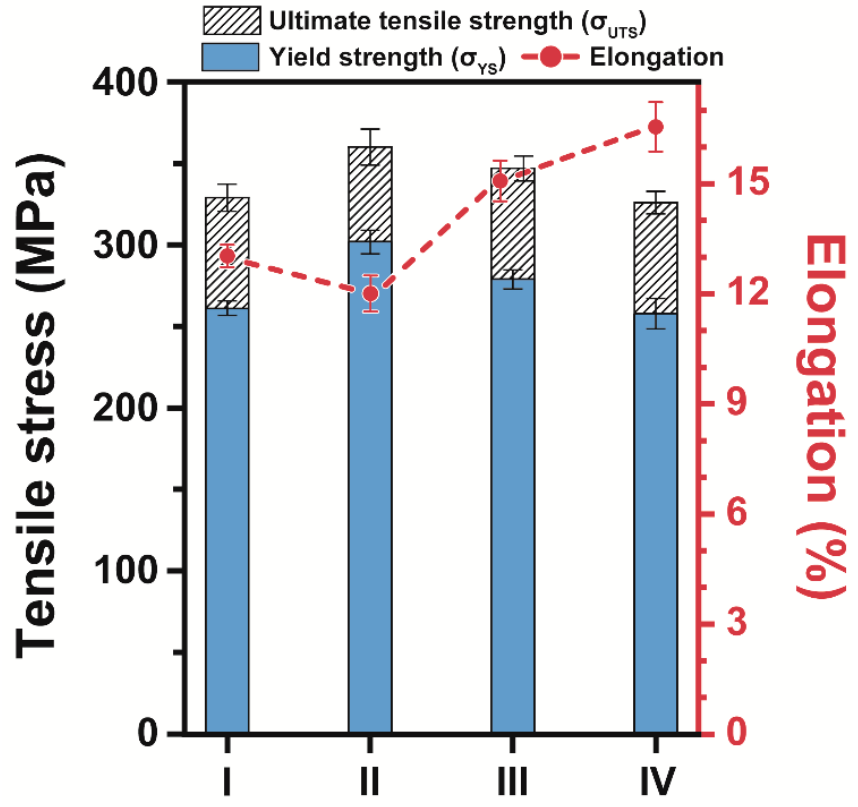
Figure 3. Tensile properties of the synthesized alloys with respect to the various values of T sol.